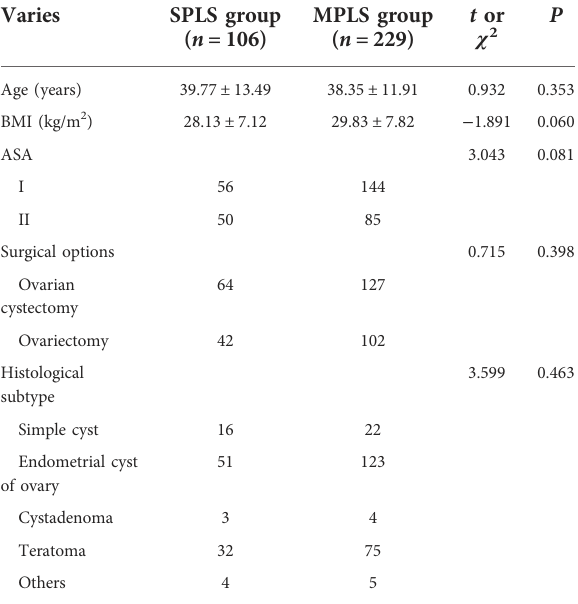
TABLE 1 Clinical characteristics of patients with benign ovarian tumor compared between the SPLS and the MPLS groups. Varies